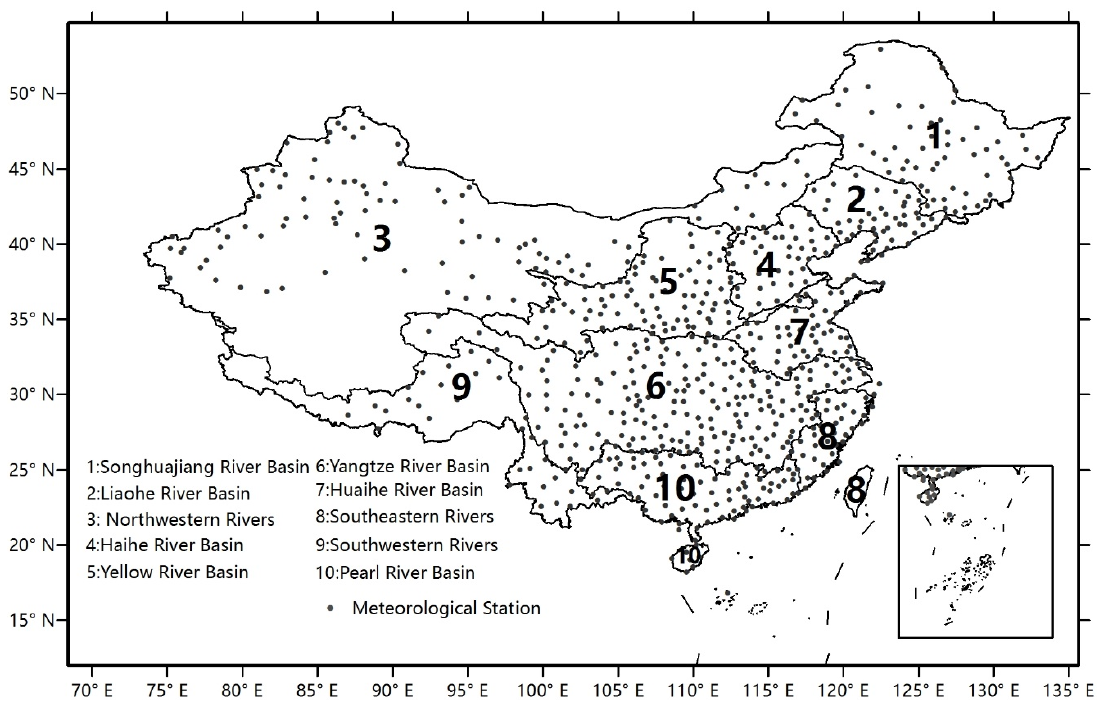
Figure 1. Large river basins and the locations of the 713 meteorological stations evaluated in China.